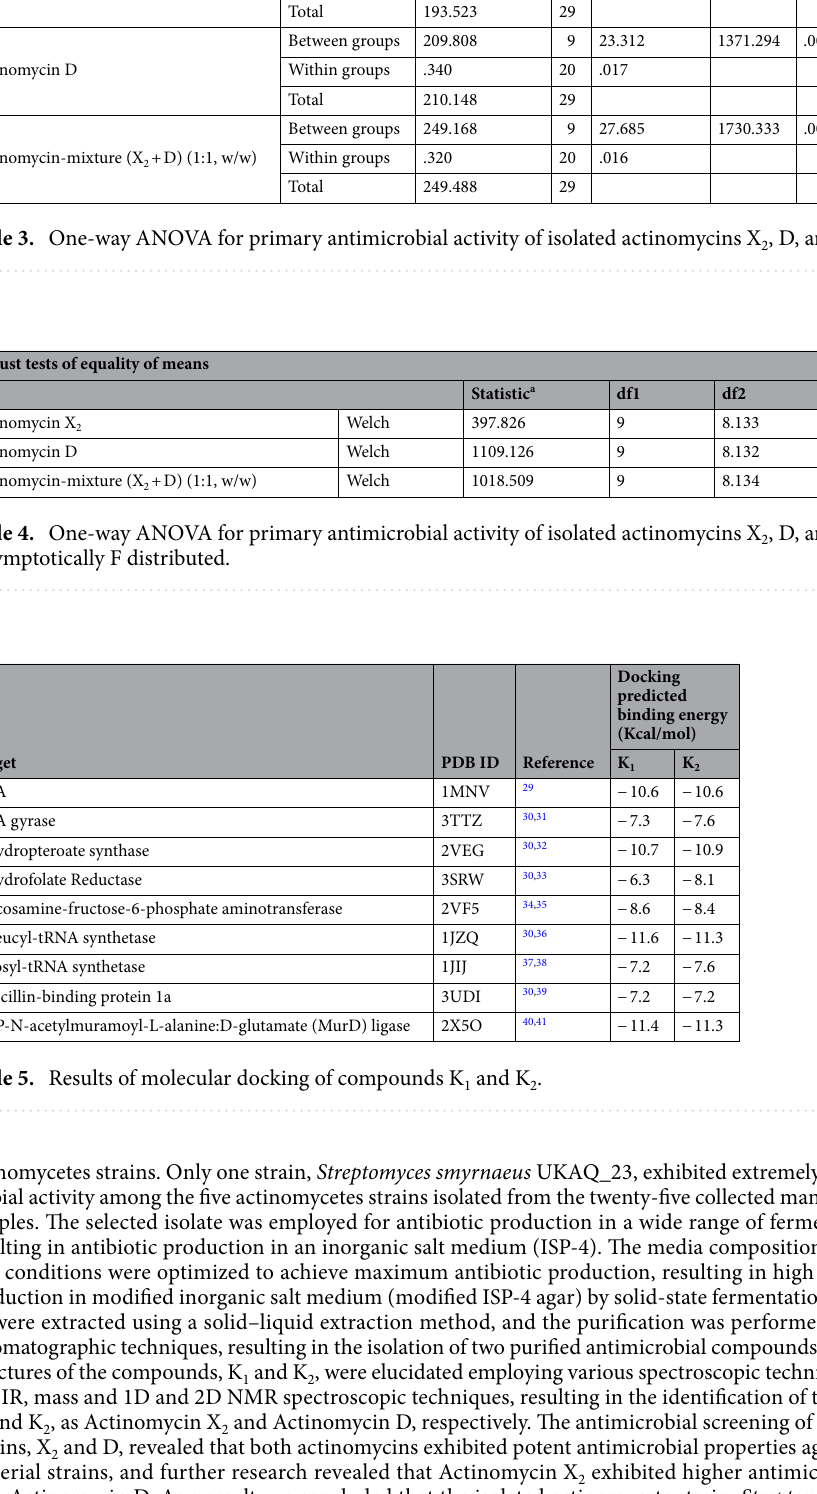
Sum of Squares df Mean Square F Sig